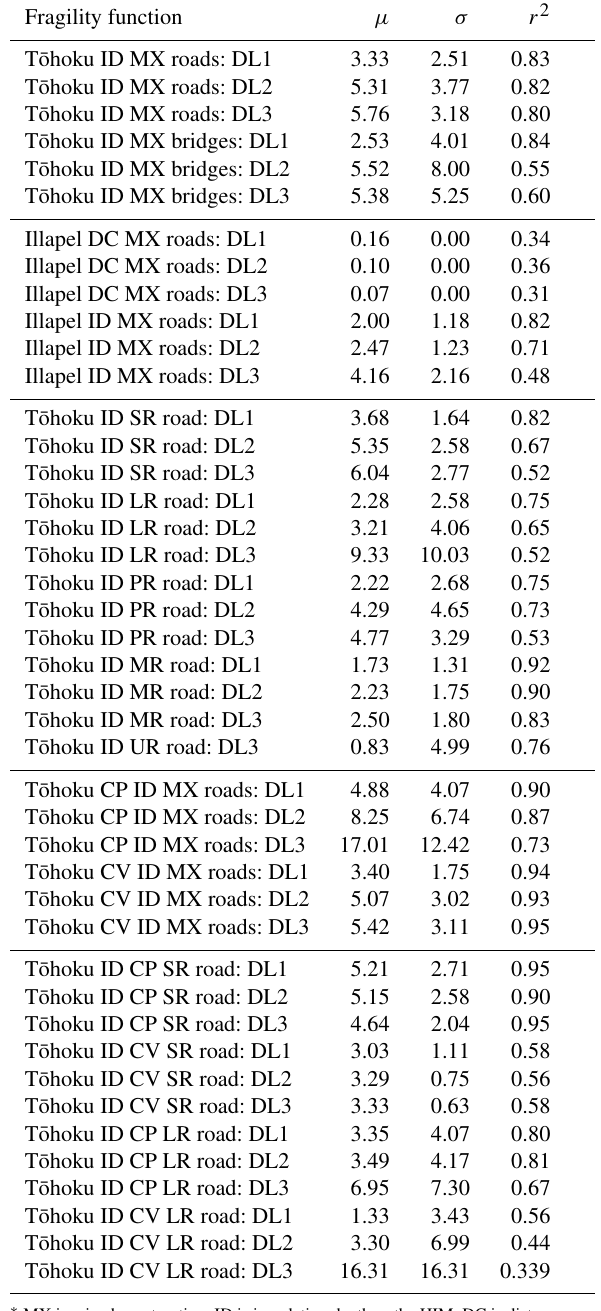
Table 3. Curve parameters for the tsunami fragility functions devel- oped for transportation assets ∗ .